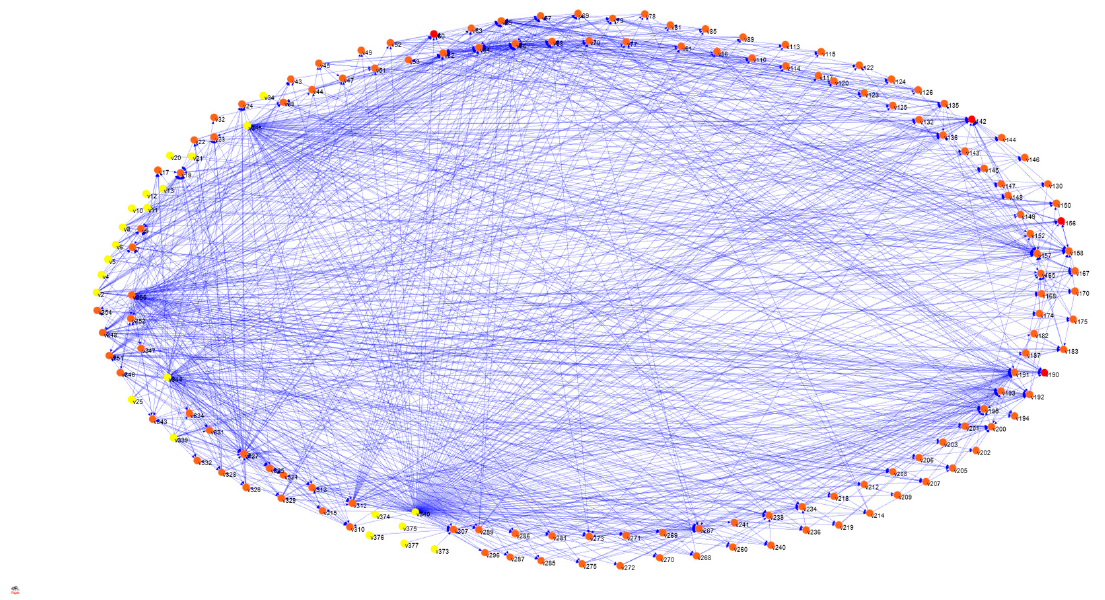
Figure 9. Mode of the PNRRGTP.